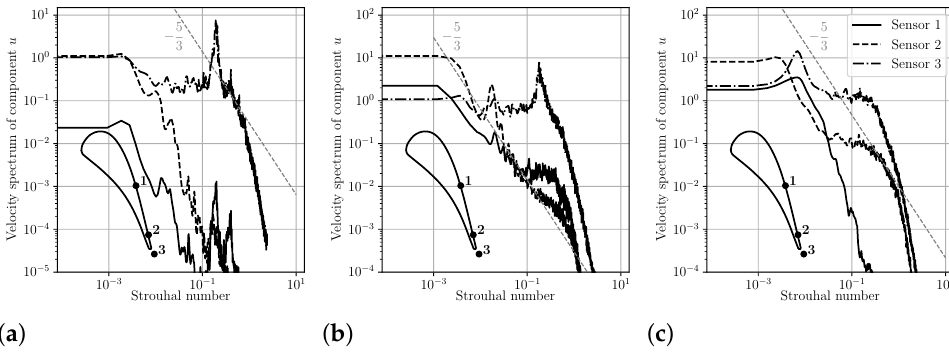
Figure 12. Velocity spectra for cases IC1-LPR ( a ), IC1-HPR ( b ), and IC2-LPR ( c ), evaluated at the three sensor locations shown in the